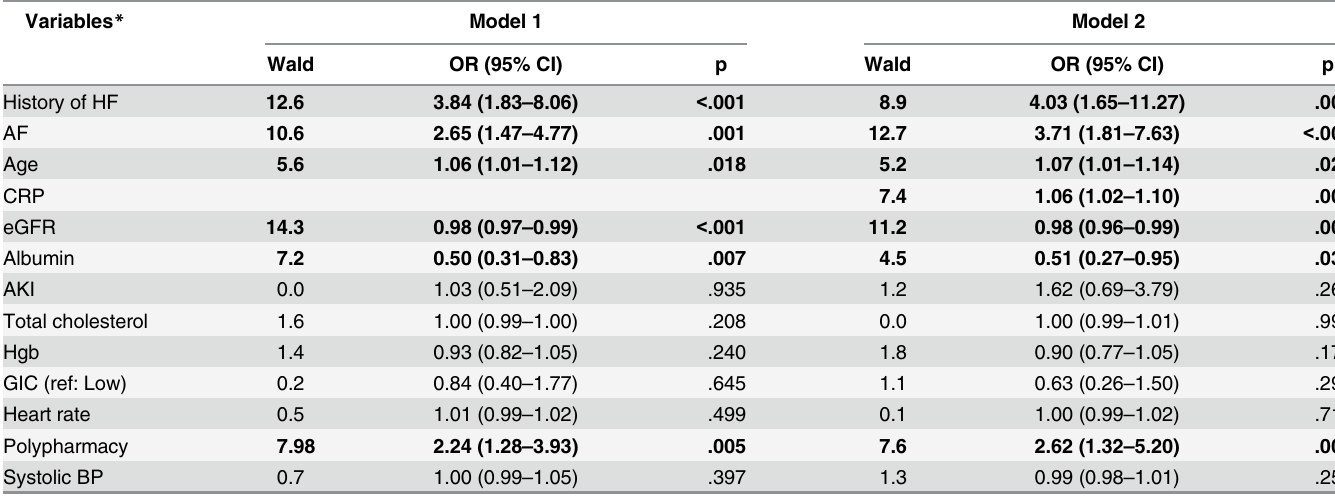
Table 2. Logistic Regression for HF (NT-proBNP (cid:1) 1800 pg/ml). Variables